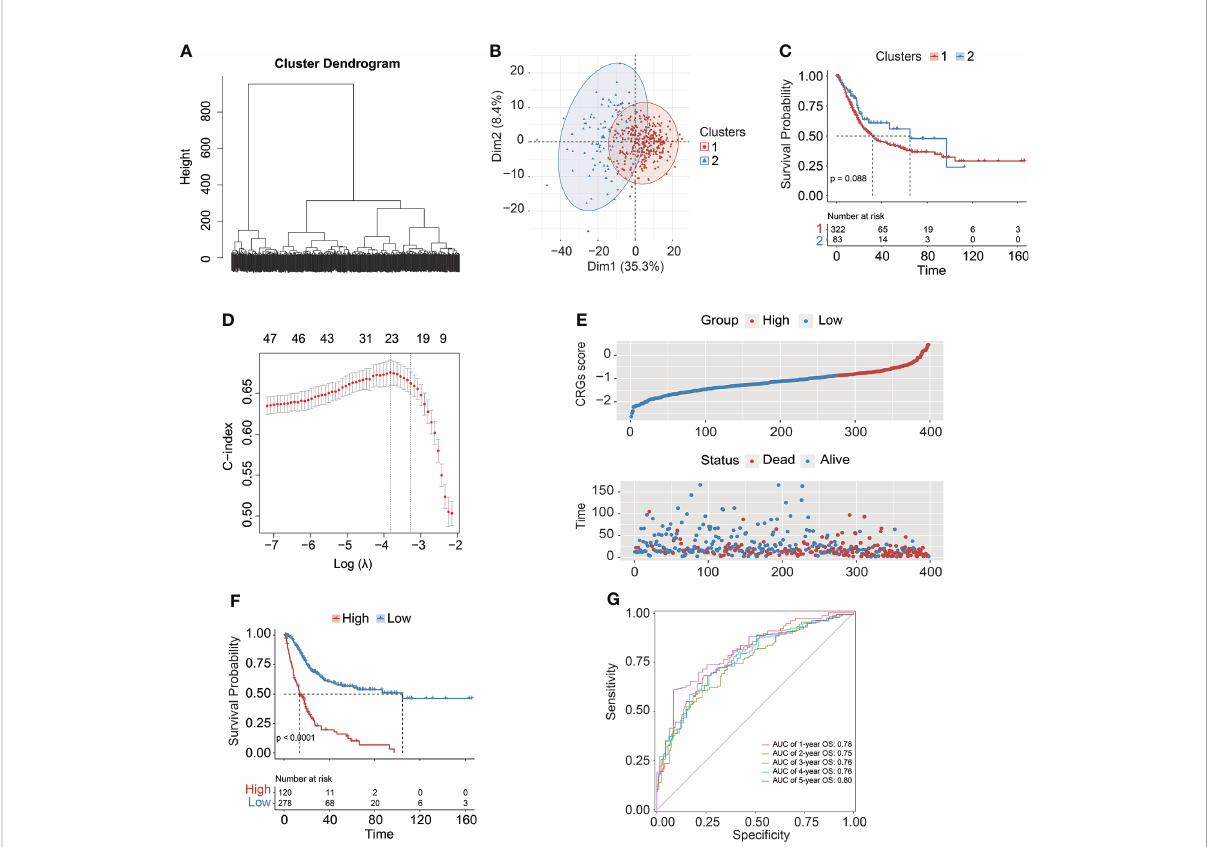
FIGURE 2 The transcriptomic pro fi ling of cell cycle checkpoint-related genes (CRGs) was correlated with overall survival (OS) of BC patients from the TCGA-BC cohort. (A) The unsupervised hierarchical clustering of BC patients based on the transcriptional characterization of CRGs. (B) The principal component analysis (PCA) showed the differentiation between clusters 1 and 2. (C) Kaplan – Meier curve analysis to compare OS between clusters 1 and 2. (D) The least absolute shrinkage and selection operator (LASSO) Cox regression analysis for construction of the prognostic CRG signature. (E) The scatterplot demonstrated the distribution of CRG scores corresponding to survival status of BC patients in the training cohort. (F) Kaplan – Meier curve analysis to compare OS between high-risk and low-risk groups. (G) The receiver operating characteristic curve (ROC) analysis for evaluating the ability of the CRG signature in prognosis